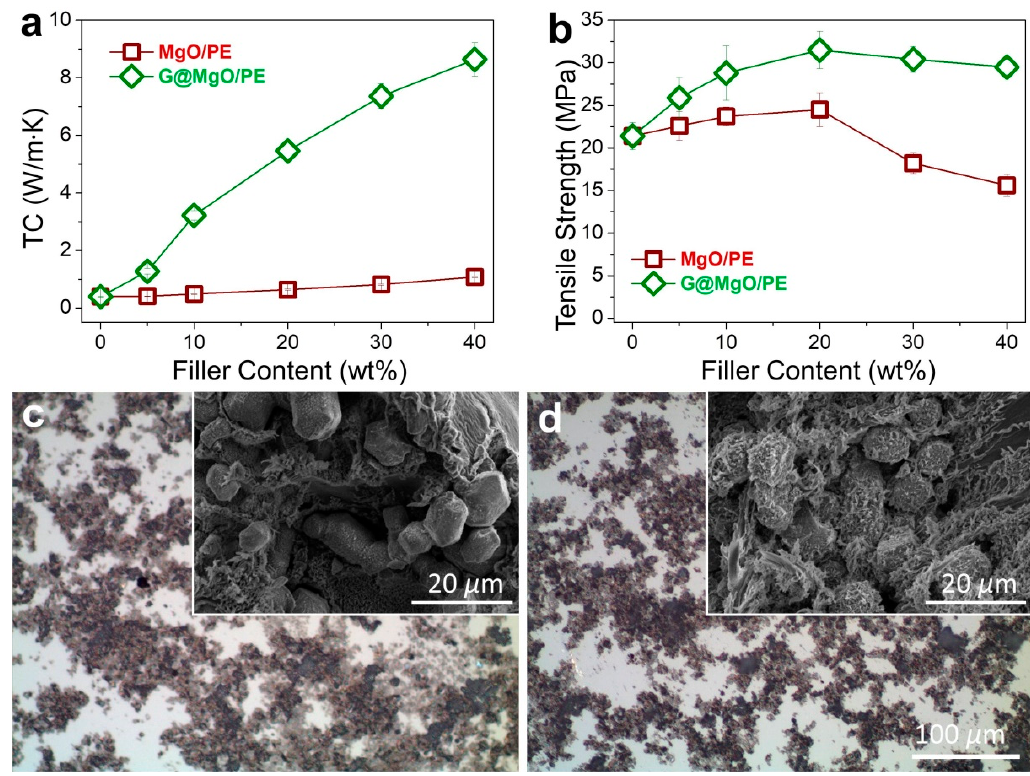
Figure 6. Property improvements of polymer composites with the assistance of G@MgO. Plots of ( a ) TC and ( b ) tensile strength as a function of the filler loadings. Optical images of ( c ) polyethylene/MgO (70/30) and ( d ) polyethylene/G@MgO (70/30) showing the improved dispersion of particles, the inset SEM micrographs display the representative fracture surfaces after tensile failure, respectively.